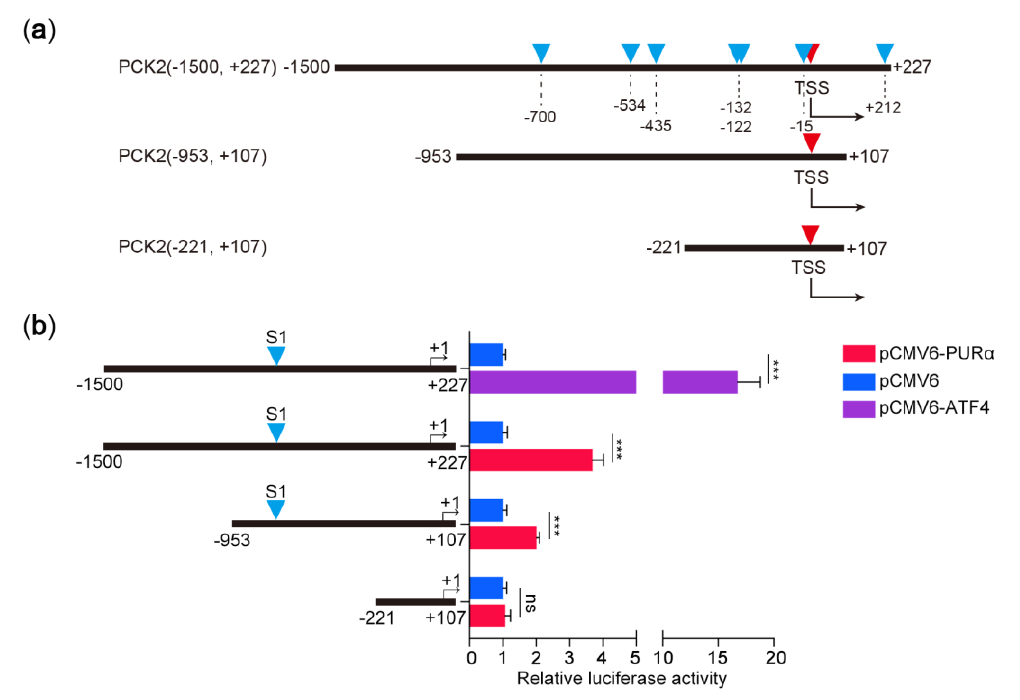
Figure 7. Identification of PUR α binding to the core promoter region of PCK2. ( a ) Schematic diagram showing the truncated region of the PCK2 promoter and 7 predicted PUR α binding sites. The red triangle represents the TSS, and the blue triangle represents PUR α predicted binding sites. ( b ) Luciferase assay of the positive control and truncated PCK2 promoter in KYSE170 cells under the condition of exogenous overexpression of pCMV6 / pCMV6-PUR α . n = 3. ***, p < 0.001; ns, p > 0.05.